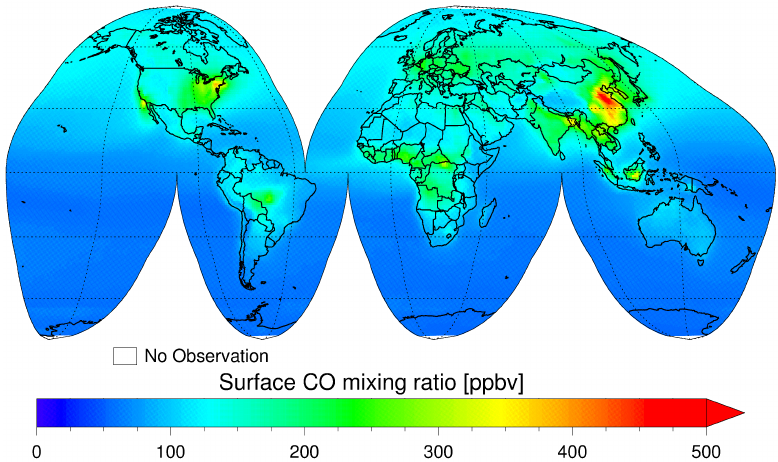
Figure 1. Total mean distribution of global surface CO from MOPITT Version 5 TIR Level 3 product, referring to daytime from 2001 to 2010.